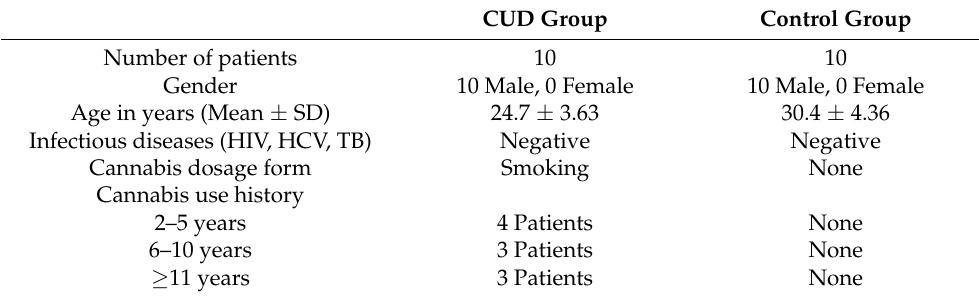
Table 1. Clinical and demographic information of the CUD and control groups recruited in the present study. HIV: Human immunodeficiency virus; HPC: Hepatitis C virus; TB: Tuberculosis. CUD